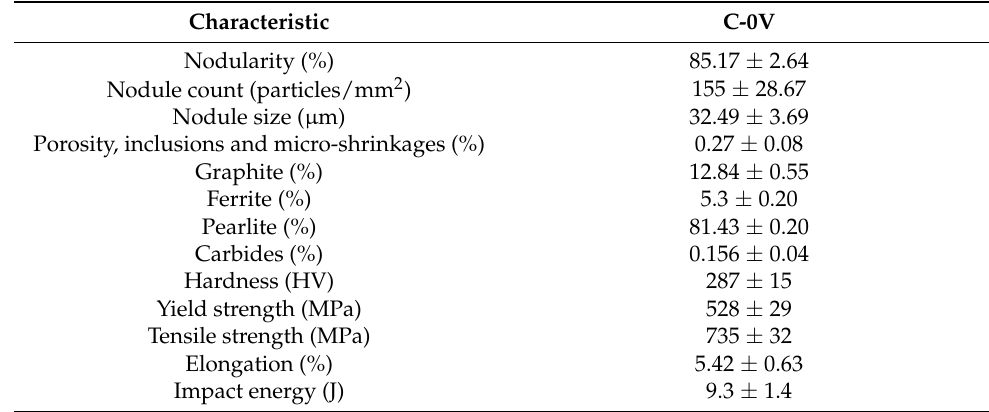
Table 2. Graphite features, the volume fraction of phases, and mechanical properties for the stan- dard camshaft.